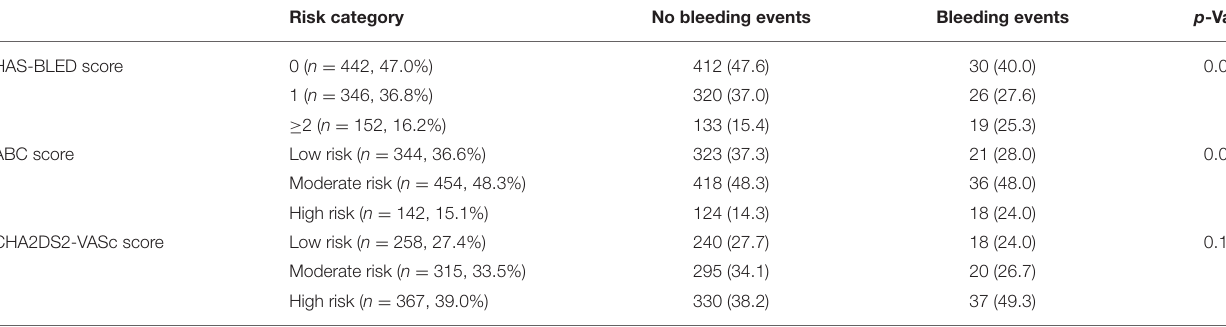
TABLE 3 | Distribution of bleeding events according to HAS-BLED, ABC and CHA2DS2-VASc score categories.